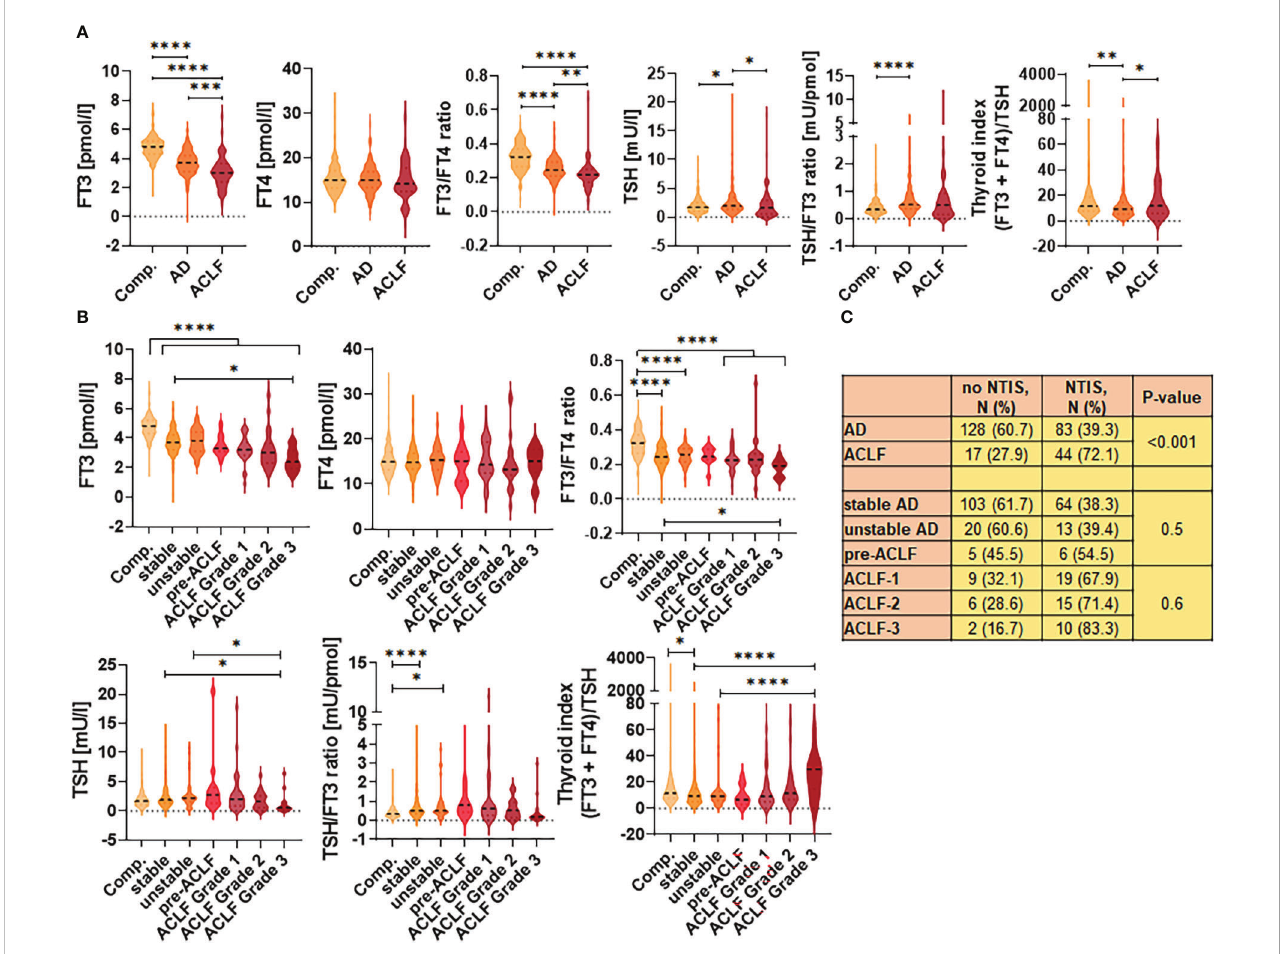
FIGURE 1 Development of thyroid hormone disbalance during progression of liver cirrhosis. (A) Violin blots of thyroid hormone concentrations according to the stage of liver cirrhosis. (B) Thyroid hormone concentrations are shown for subgroups of acute decompensation (AD) [stable AD, unstable AD and pre- ACLF], as well as for patients with ACLF grade 1-3. Graphs show value distribution with median (black dashed line) ± quartiles (colored dashed lines). One-way ANOVA or Kruskal-Wallis test were used as appropriate after Normality Test. *P ≤ 0.05, **P ≤ 0.01, ***P ≤ 0.001, ****P ≤ 0.0001. (C) Frequencies of non-thyroidal illness syndrome (NTIS) according to the stage of liver cirrhosis. ACLF, acute-on-chronic liver failure. AD, acute decompensation; Comp., compensated cirrhosis; FT3, free triiodothyronine; FT4, free tetraiodothyronine; TSH, thyroid-stimulating